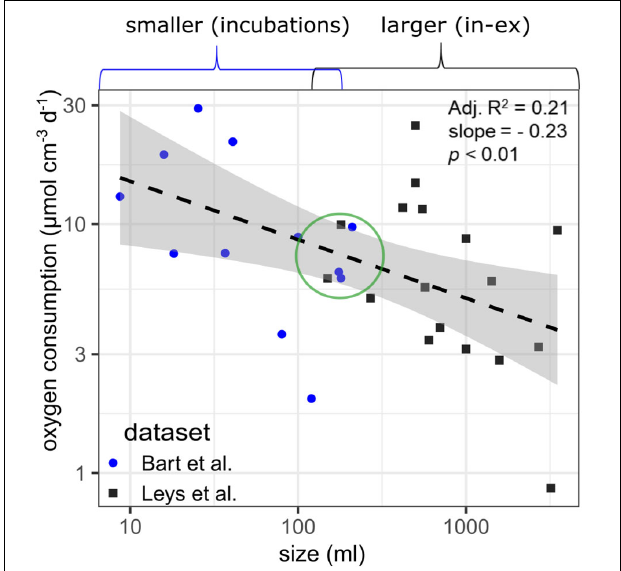
FIGURE 2 | Regression between sponge volume (cm − 3 ) and measured volume-specific oxygen consumption ( µ mol O 2 cm − 3 day − 1 ) in Geodia barretti by Bart et al. (2020b) (blue circles) and Leys et al. (2018) (dark gray squares). Log-log linear models were used to fit all data (dashed black line). The gray zones indicate the 95% confidence interval. The green circle indicates that the two methods (incubation chambers and in–ex) can produce consistent results (despite the large